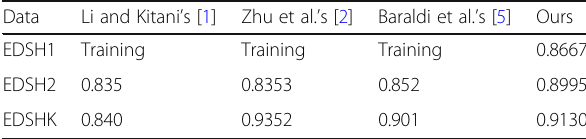
Table 1 Comparison with state of the art on F -score